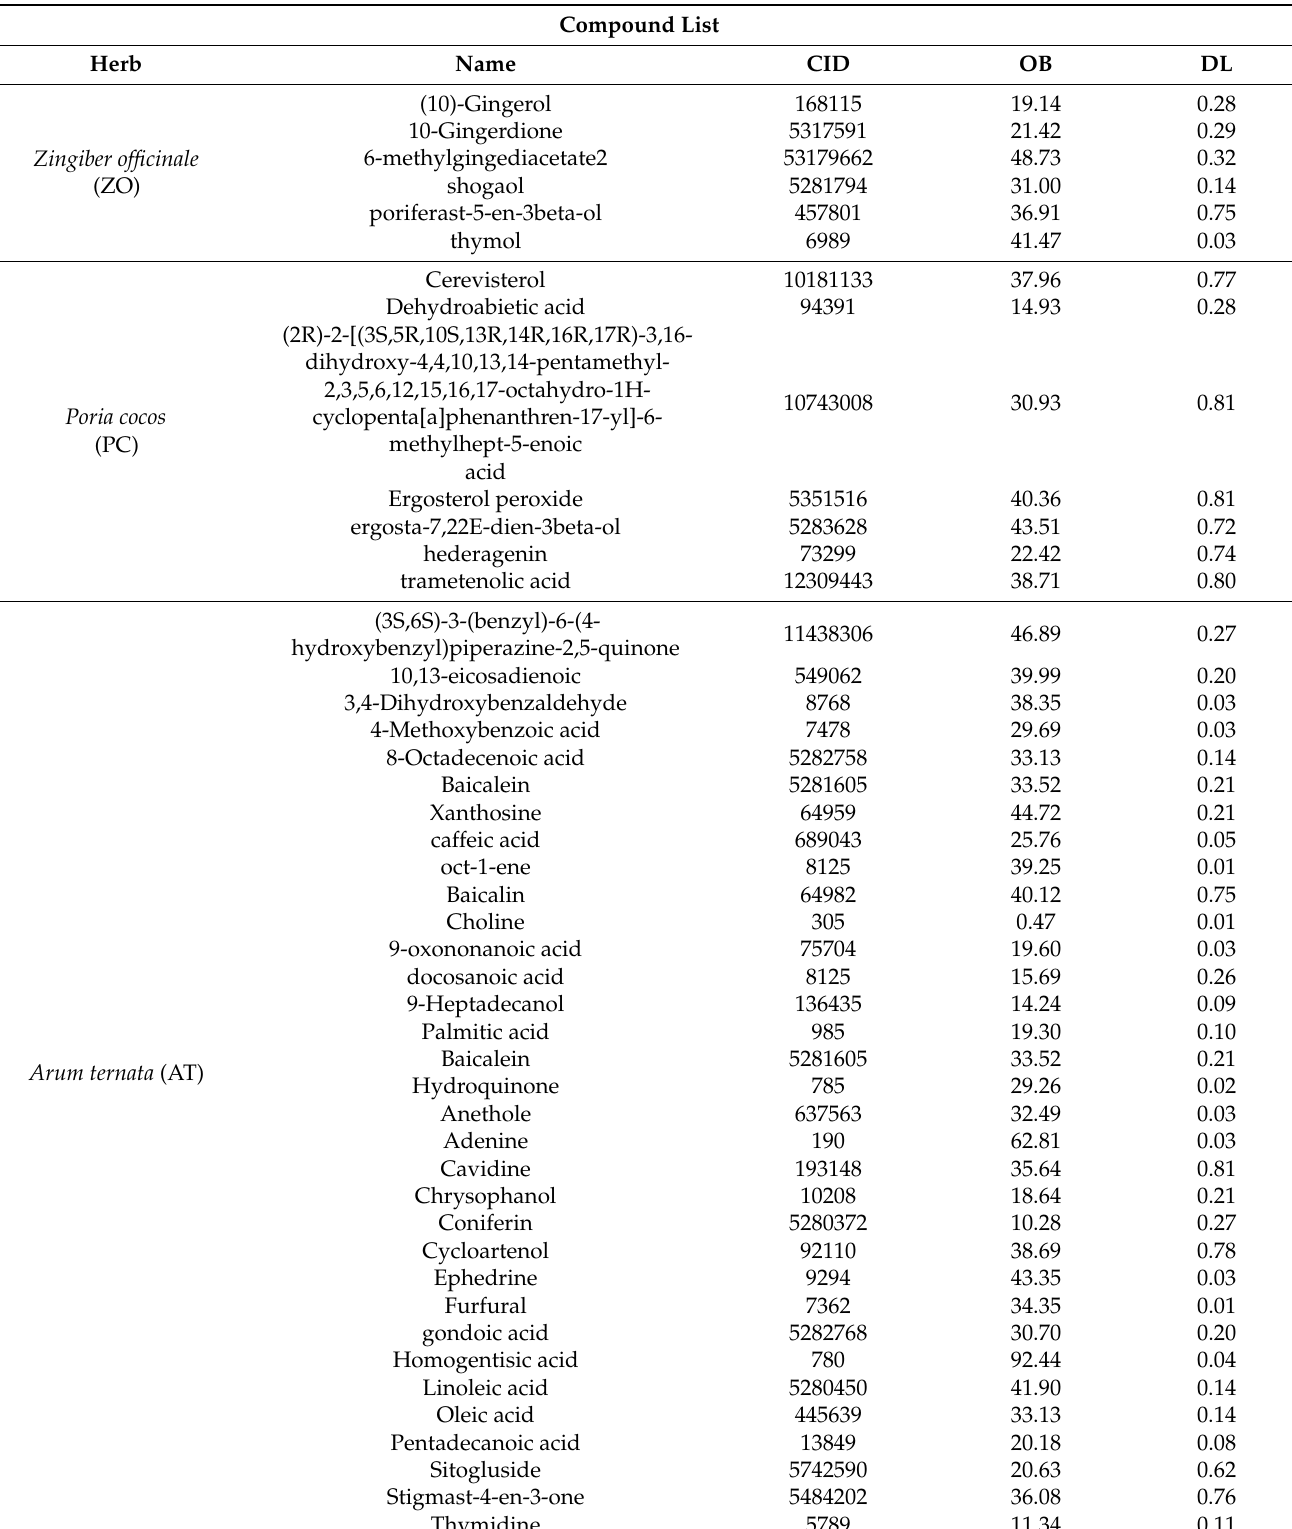
Table 1. Compounds of Zingiber officinale , Poria cocos and Arum ternata . Compound